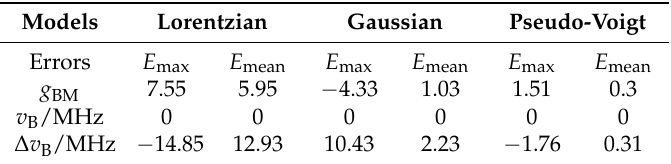
Table 1. Statistical results of relative errors in the key parameters extracted by different model-based